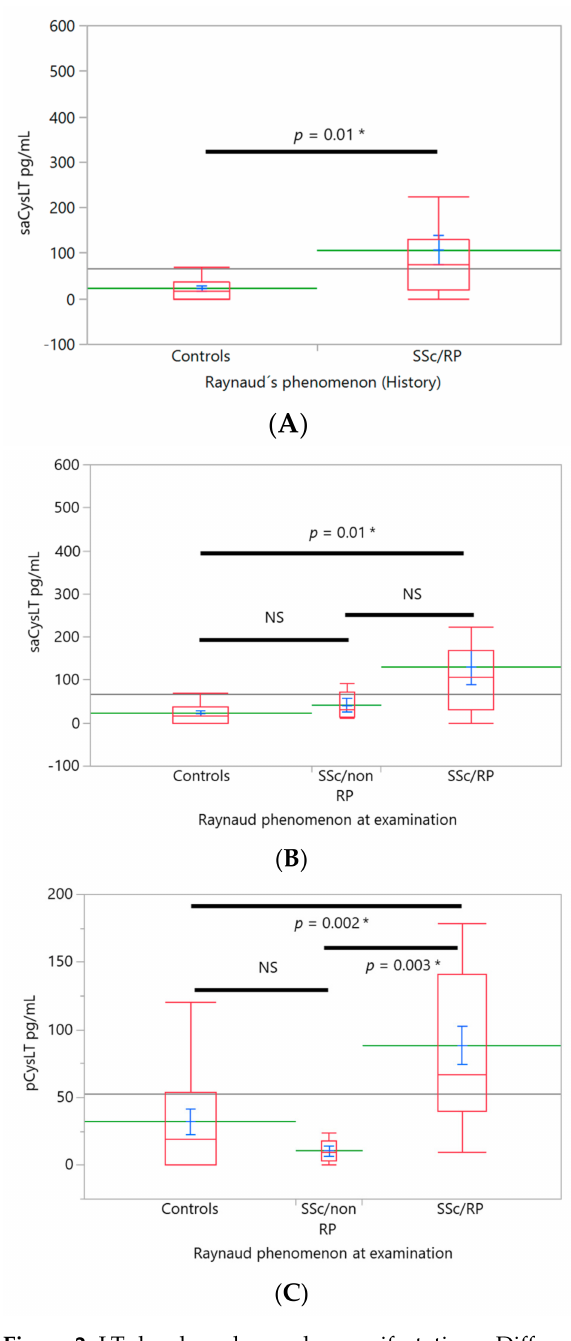
Figure 2. LTs levels and vascular manifestations. Differences in levels of leukotrienes according to the presence or absence of vascular manifestations that showed statistical differences. Box plots (red), mean (green), mean error bars (blue) and grand mean (grey line across the boxes) are shown. The X axis is proportional. Overlap marks are drawn to illustrate statistical differences between the groups. Levels of CysLT in salivary samples in SSc with RP history were compared to controls ( A ). saCysLT levels between the groups of SSc with (SSc/RP) and without (SSc/non RP) RP at examination and control group were compared ( B ). Levels of pCysLT were compared between groups: with or without RP at examination, and control group ( C ). Analysis of covariance (ANCOVA) was used for analysis and Tukey HSD test was used to detect the differences between all pairs. RP: Raynaud ´ s phenomenon, LTs: leukotrienes, CysLT: cysteinyl-leukotrienes, sa: salivary, p: plasmatic, NS: non-significant, *: to denote statistically significant